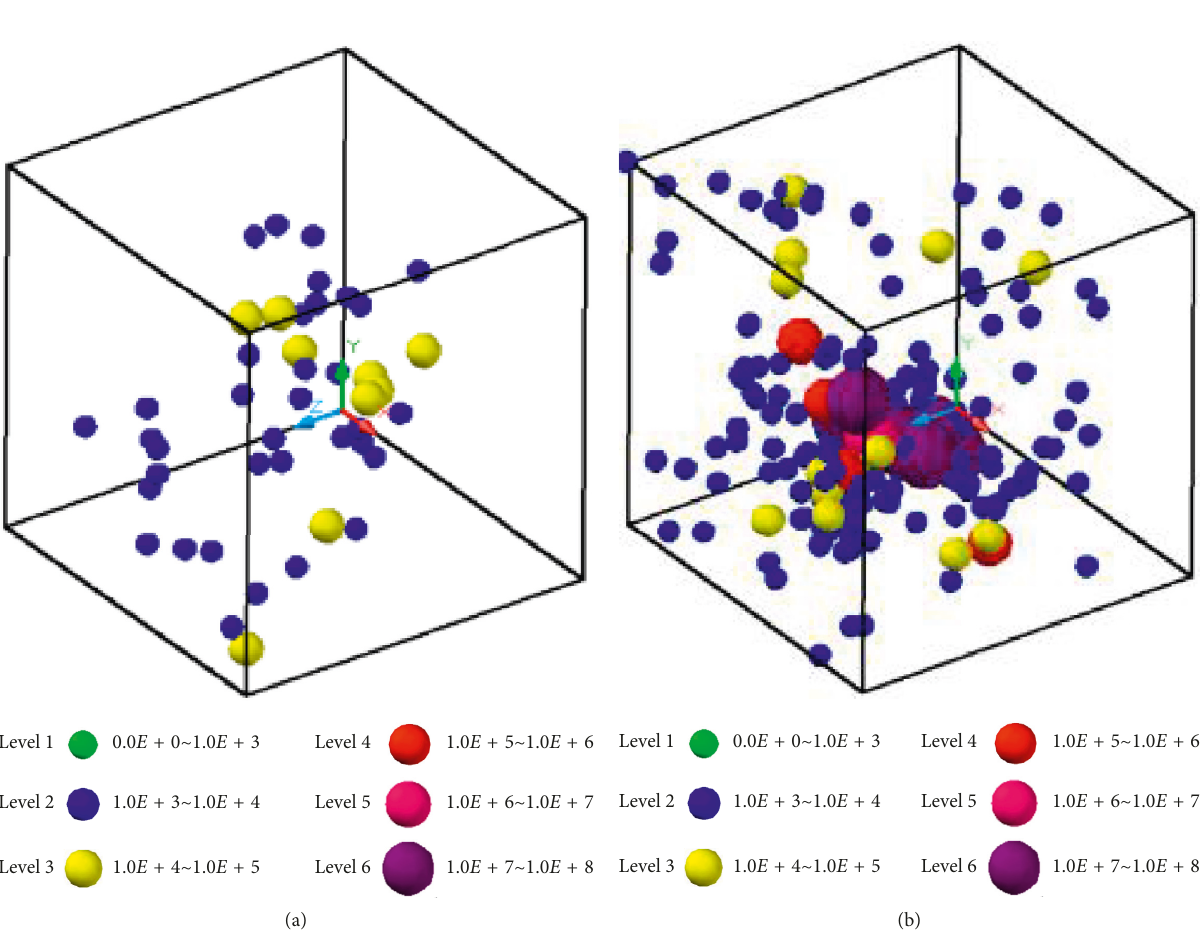
Figure 5: AE event locations of nonbursting and bursting coal samples: (a) nonbursting sample C;(b) bursting sample M; (c)